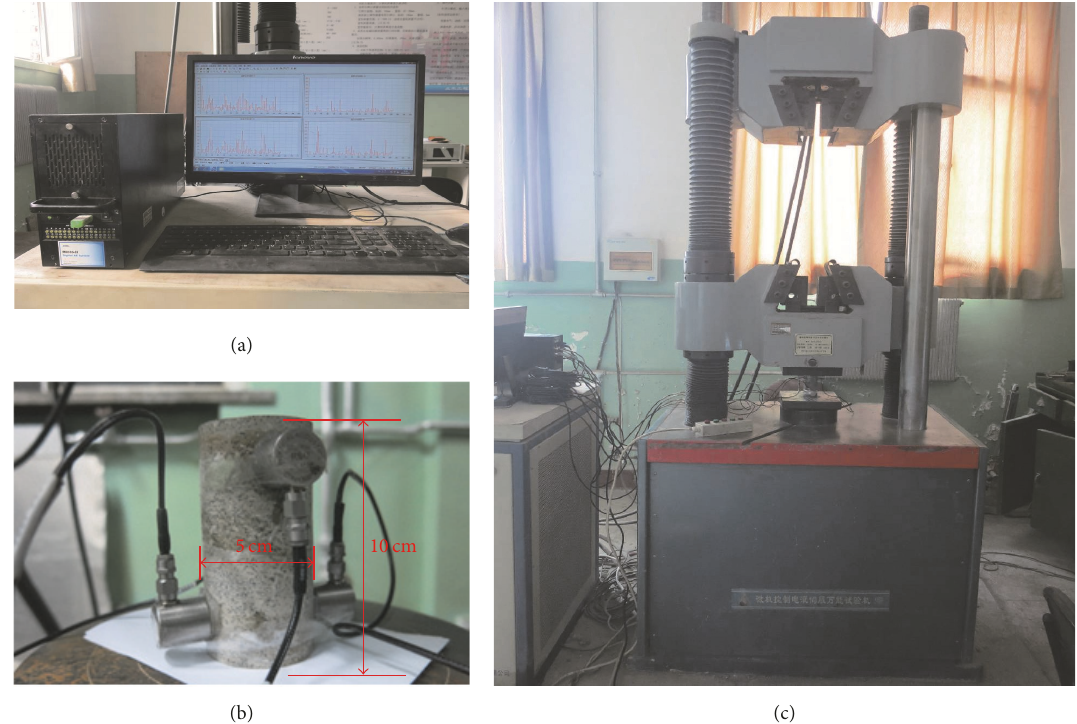
Figure 4: Scheme of the testing system. Micro-II digital AE system (a), position of AE sensors (b), and WAW-1000 conventional mechanical rigid testing machine